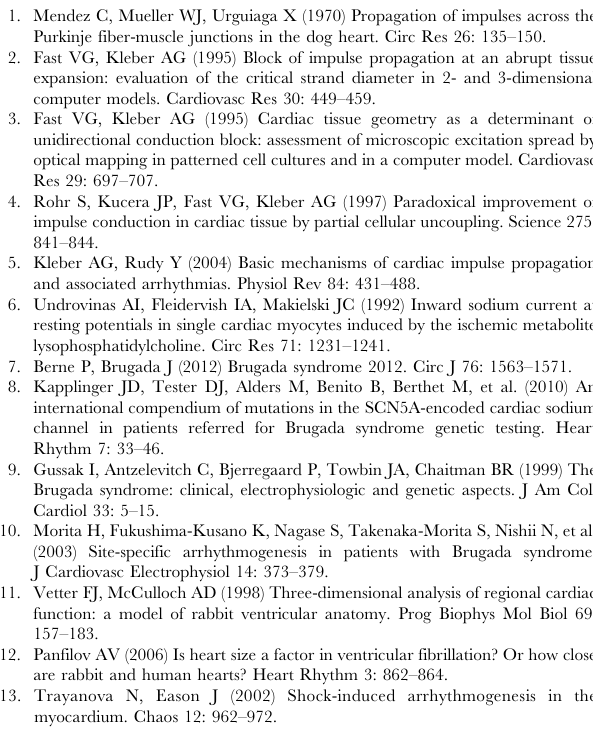
system. I Na : cardiac sodium current. Figure S2: (A) Examples of Q thr (t A ) functions derived by linear interpolation for different CI values showing differences in slope and y-intercept (r 2 . 0.99 in all cases). (B & C) Slope and y-intercept values from panel A (gold squares), along with many others (red squares), are used to derive estimator functions for Q thr (t A ,CI), as explained in Methods section. All values shown here were generated from single-cell simulations with 30% I Na . Sixth-order polynomial fits for these data sets (blue; r 2 . 0.99) are given by the following two equations: